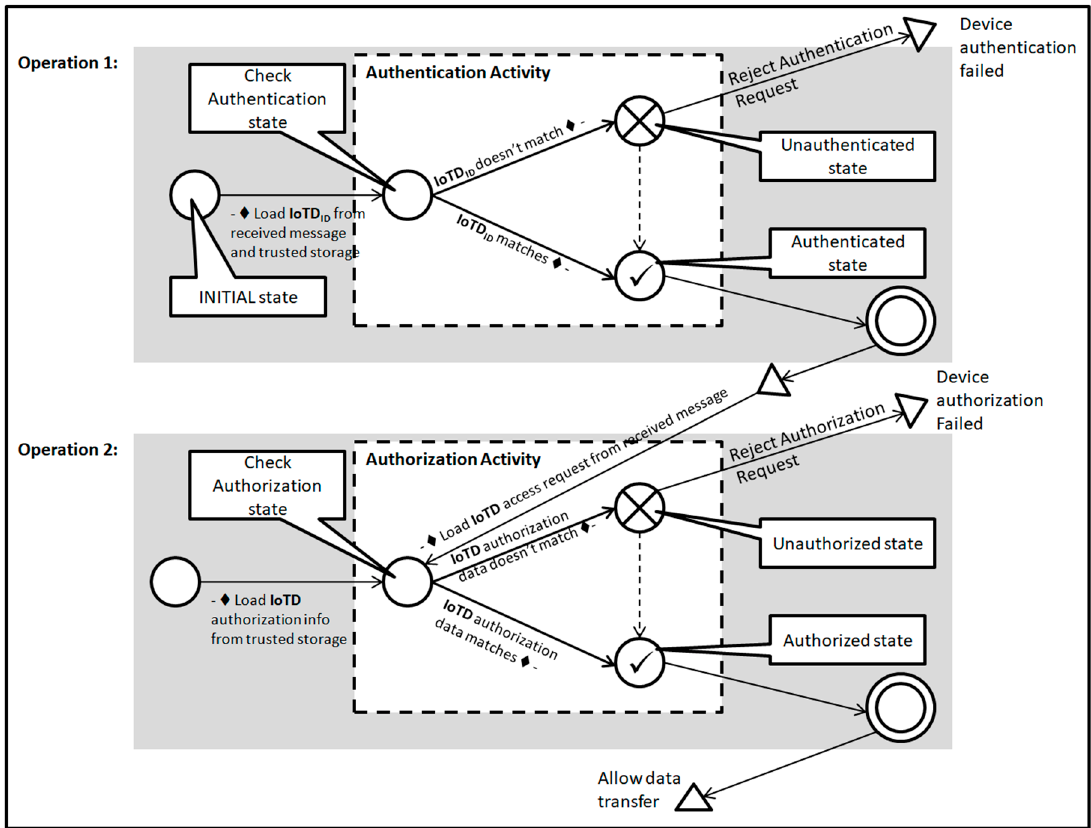
Figure 10. Authentication and authorization for IoT device (IoTD) at edge IoT gateway (EIoTG).